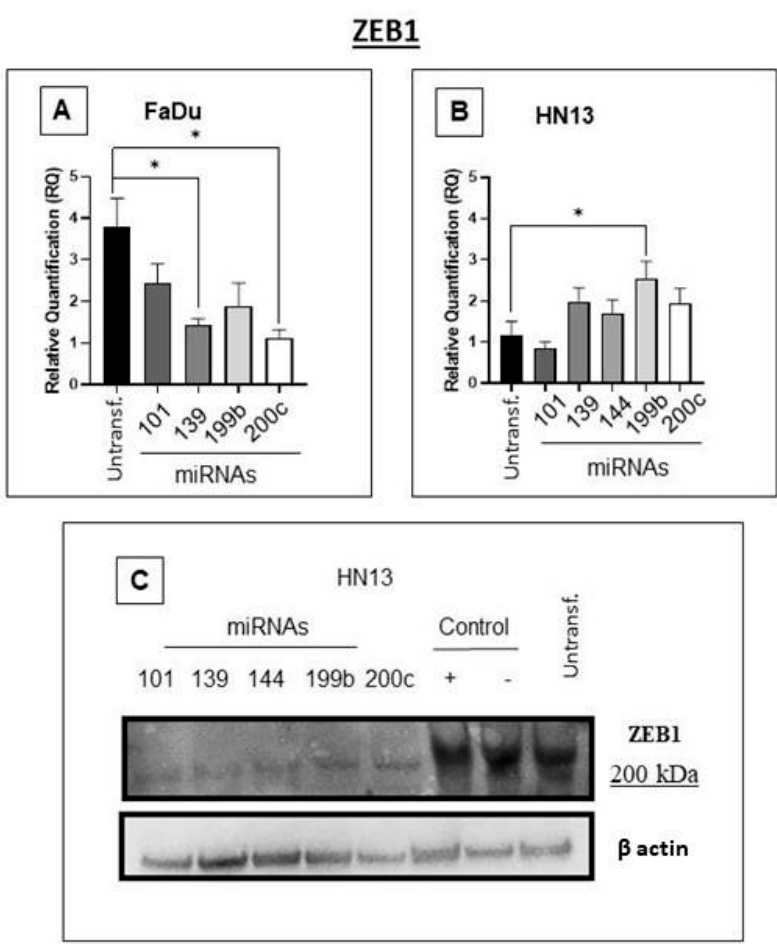
Figure 1. Based on bioinformatics analysis, we investigated five miRNAs as potential ZEB1 regulators (miR-101-3p, miR-139-5p, miR-144-3p, miR-199b-5p, and miR-200c-3p). ( A ) In the pharyngeal cancer cell line (FaDu), miR-139-5p and miR-200c-3p significantly downregulated ZEB1 mRNA; however, this was not observed for other miRNAs (t- test *, p = 0.02, *, p = 0.01, and ns, p > 0.05, respectively). ( B ) For the oral cancer cell line HN13, transfection with miR-199b-5p significantly upregulated ZEB1 mRNA expression, but transfection with other miRNAs showed no statistical significance ( t -test *, p = 0.02, and ns, p > 0.05, respectively). ( C ) HN13 transfected with miRNAs (miR-101-3p, miR-139-5p, miR-144-3p, miR-199b-5p, and miR-200c-3p) and downregulated ZEB1 protein levels as observed by Western blot assay.